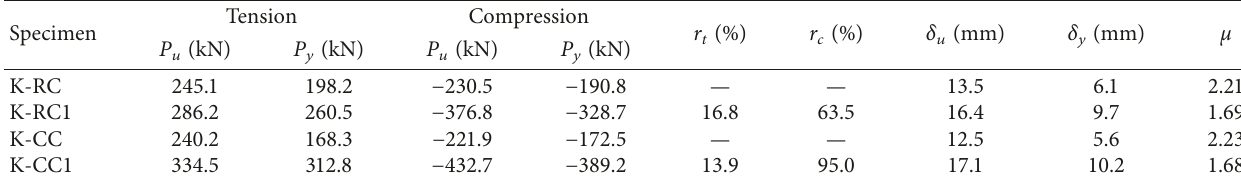
Figure 6: The hysteretic curves of the joints. (a) K-RC, (b) K-RC1, (c) K-CC, and (d) K-CC1. Table 3: The control load and displacement ductility coefficient of